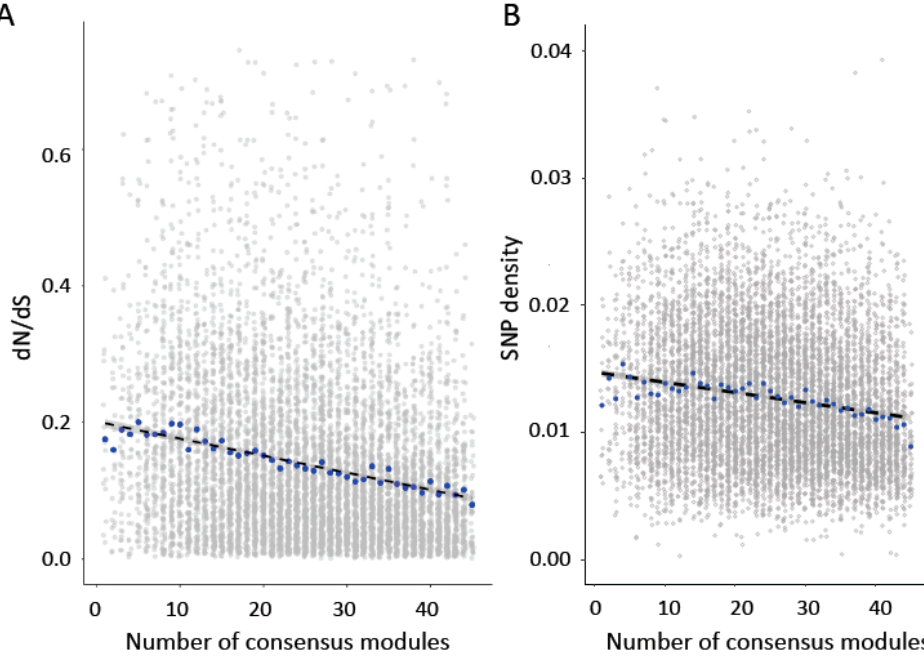
Figure 3. ( A ) Genes in more consensus modules show significantly lower dN/dS values (Pairwise Spearman’s rank correlation rho = − 0.22, p < 2.2 × 10 − 16 ; Partial Spearman rho = − 0.11, p < 2.2 × 10 − 16 ). ( B ) Genes in more consensus modules also show significantly lower SNP density (Pairwise Spearman’s rank correlation rho = − 0.16, p < 2.2 × 10 − 16 ; Partial Spearman rho = − 0.039, p = 0.00036). Blue points indicate median